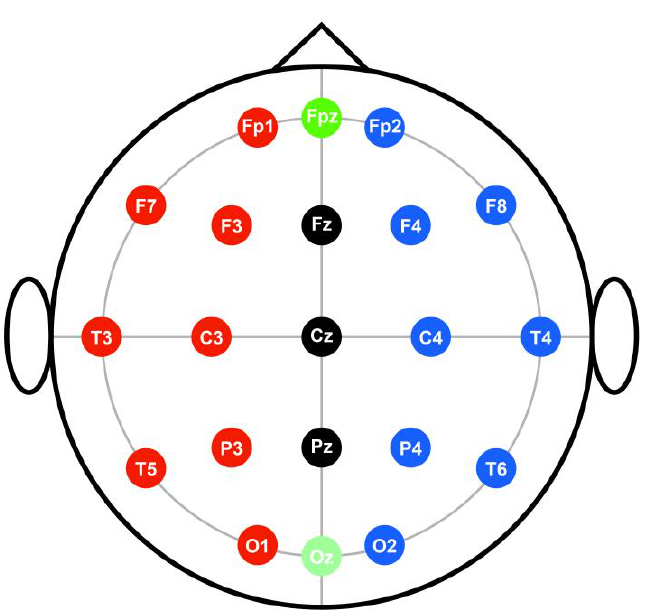
Figure 3. Electroencephalography (EEG) international 10–20 method. Electrodes were attached to Fp1, Fp2, F7, F3, FZ, F4, F8, T3, C3, CZ, C4, T4, T5, P3, PZ, P4, T6, O1, O2.